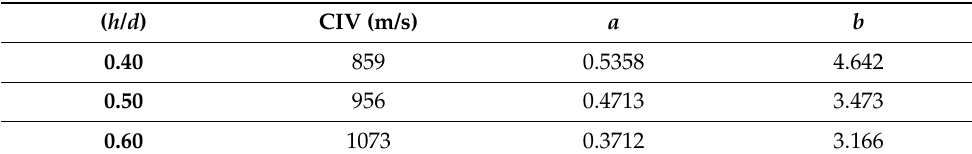
Table 4. Summary of parameters for the RI equation.